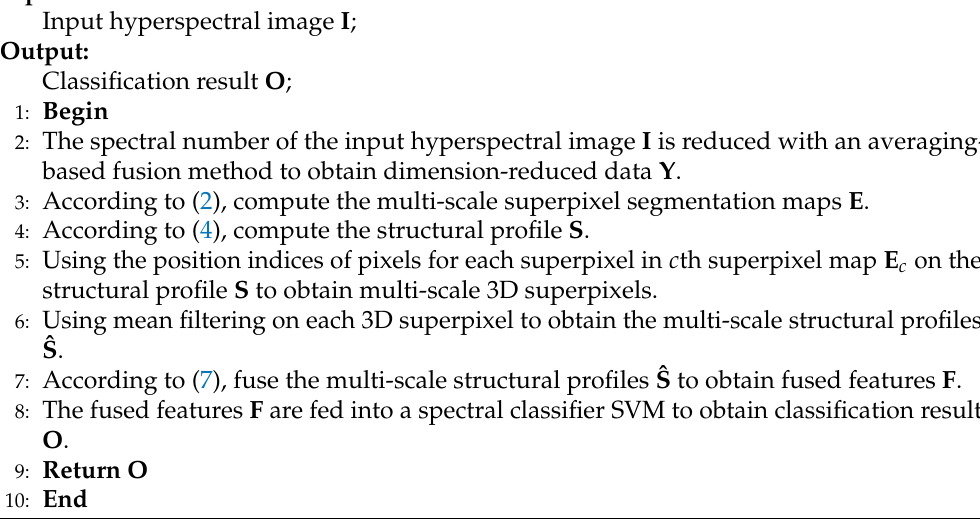
Algorithm 1 Multi-scale superpixels-guided structural profiles for hyperspectral image clas-